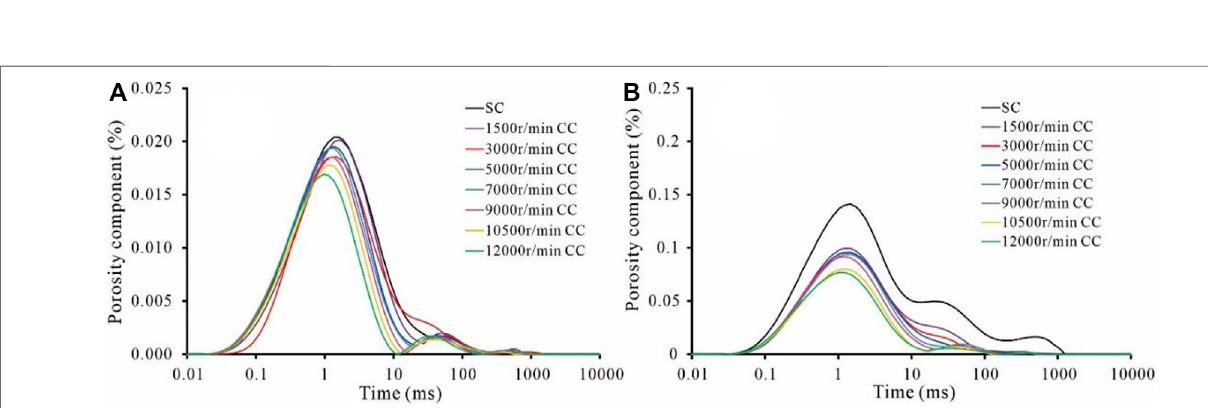
Frontiers in Earth Science |